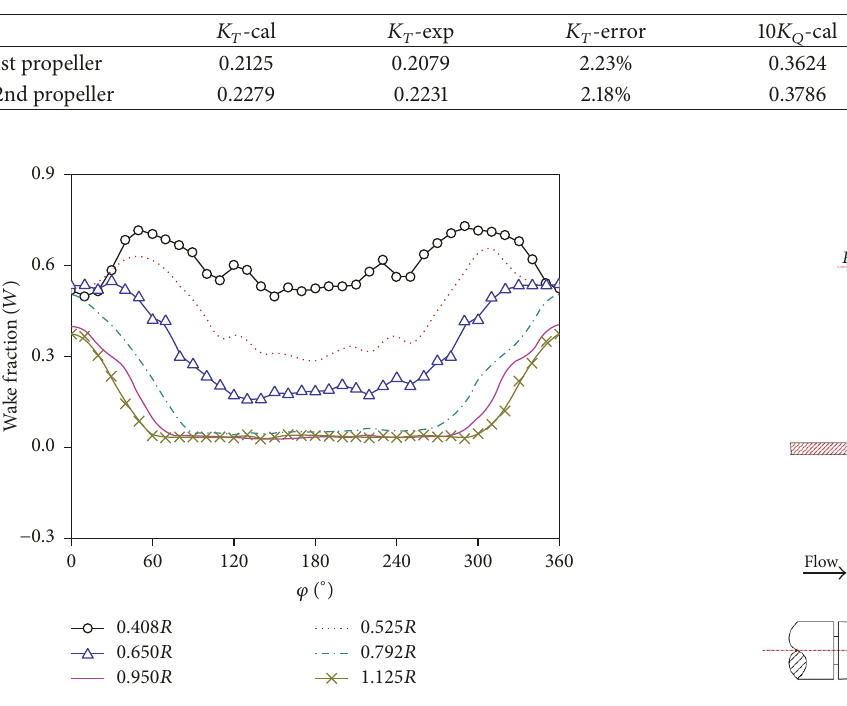
Figure 3: Propeller models for experiments: (a) 1st propeller model. (b) 2nd propeller model. Table 2: Time-averaged results of hydrodynamic performance.